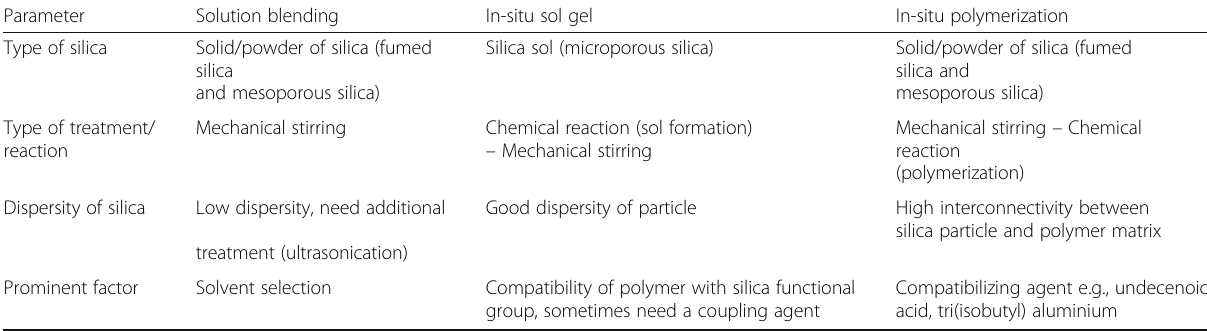
Table 4 Comparison between three MMM fabrication methods containing silica